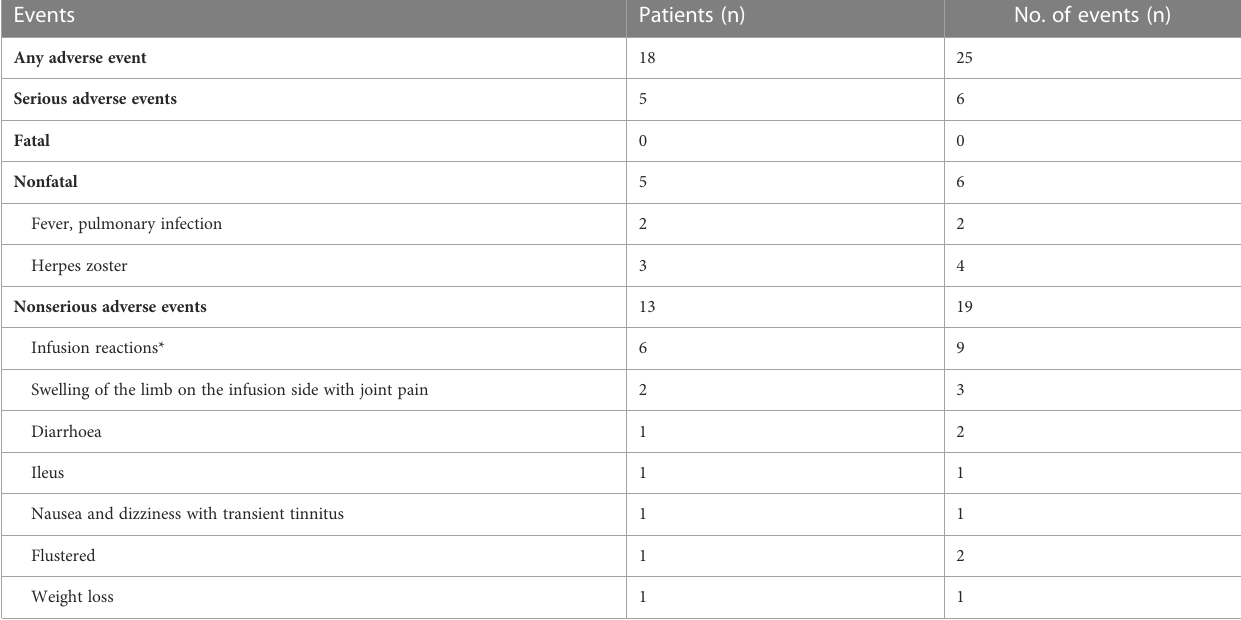
TABLE 6 Adverse events in all patients with PMN receiving rituximab.